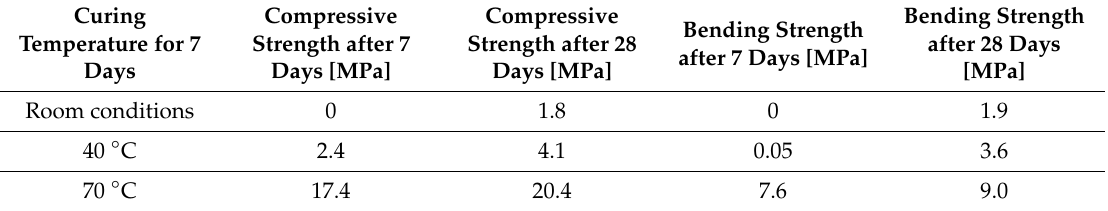
Table 3. The compressive and bending strengths of alkali activated samples from fraction 1 mm to 2 mm, in dependence of curing temperature and elapsed time.